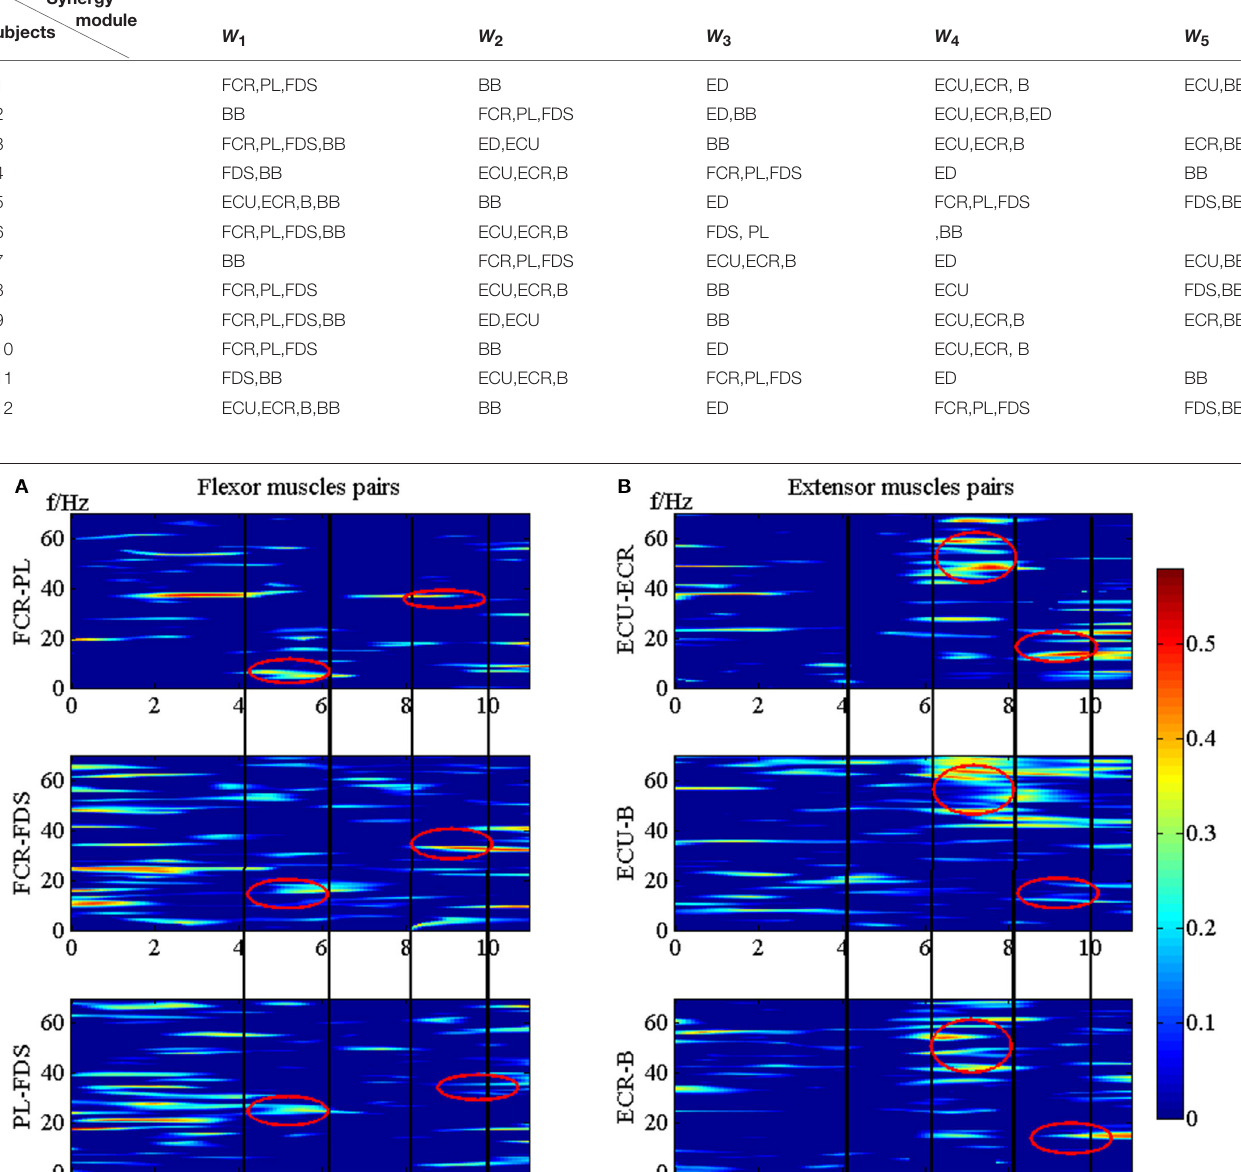
TABLE 2 | The synergistic muscles of all subjects.